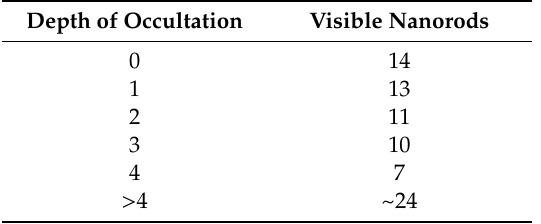
Table A1. Obscuration of nanorods, as derived from Figure